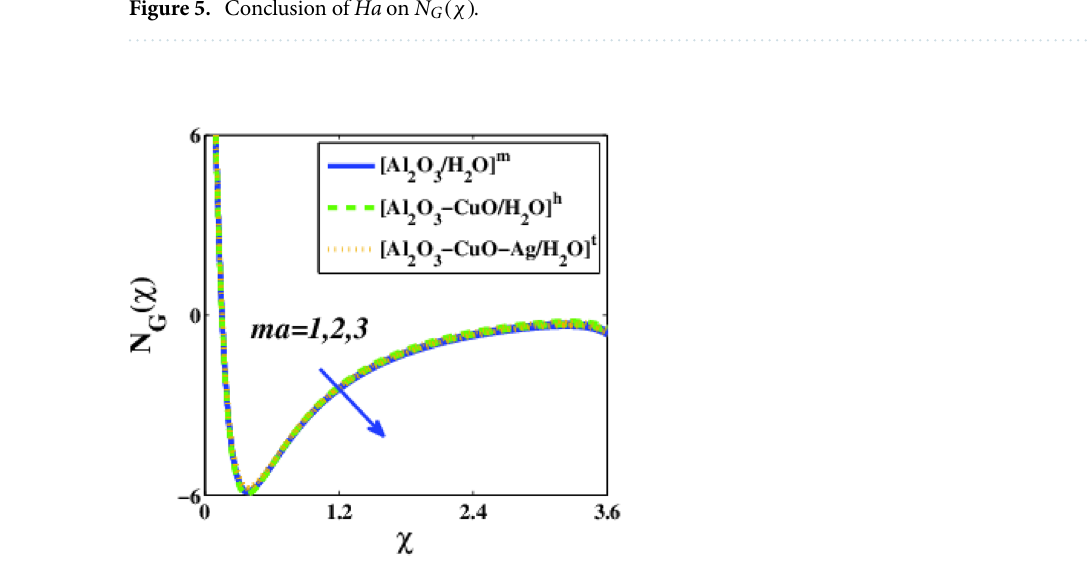
Figure 6. Influence of ma on N G (χ)